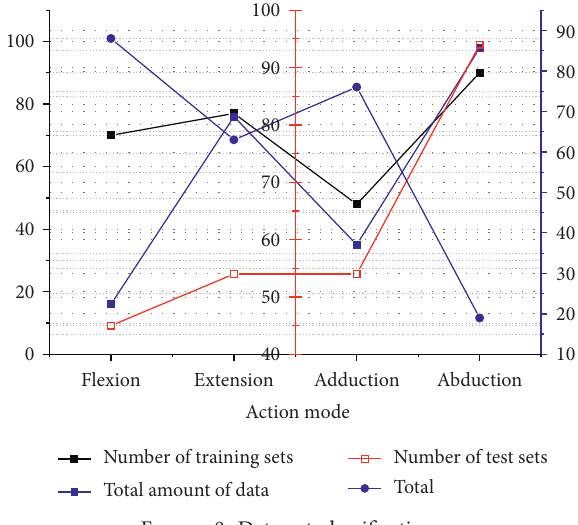
Figure 8: Data set